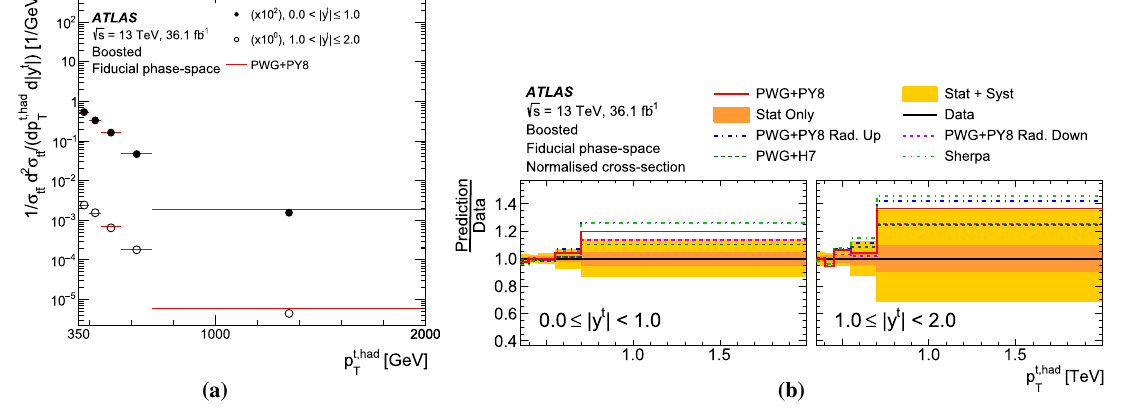
are placed at the centre of each bin. b The ratio of the measured cross- section to different Monte Carlo predictions. The bands represent the statistical and total uncertainty in the data